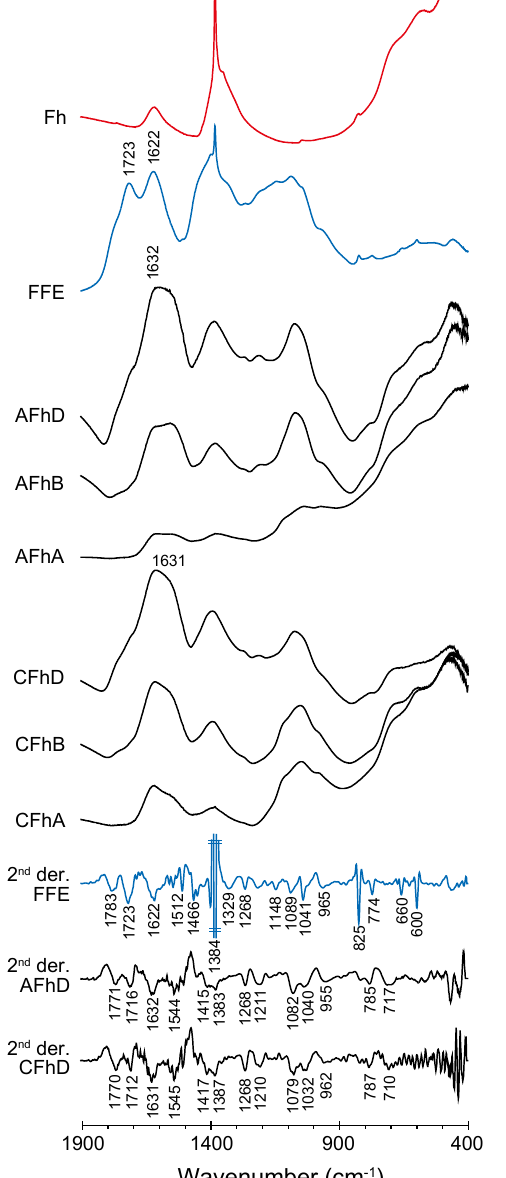
Figure 2. FTIR spectra of the control ferrihydrite (Fh), the orig- inal forest-floor extract (FFE), the adsorption complexes (AFhD, AFhB, AFhA), and the coprecipitates (CFhD, CFhB, CFhA). Sec- ond derivatives are given for spectra of the forest-floor extract and the two ferrihydrite-organic matter complexes with the highest C concentration. Refer to text for abbreviations.